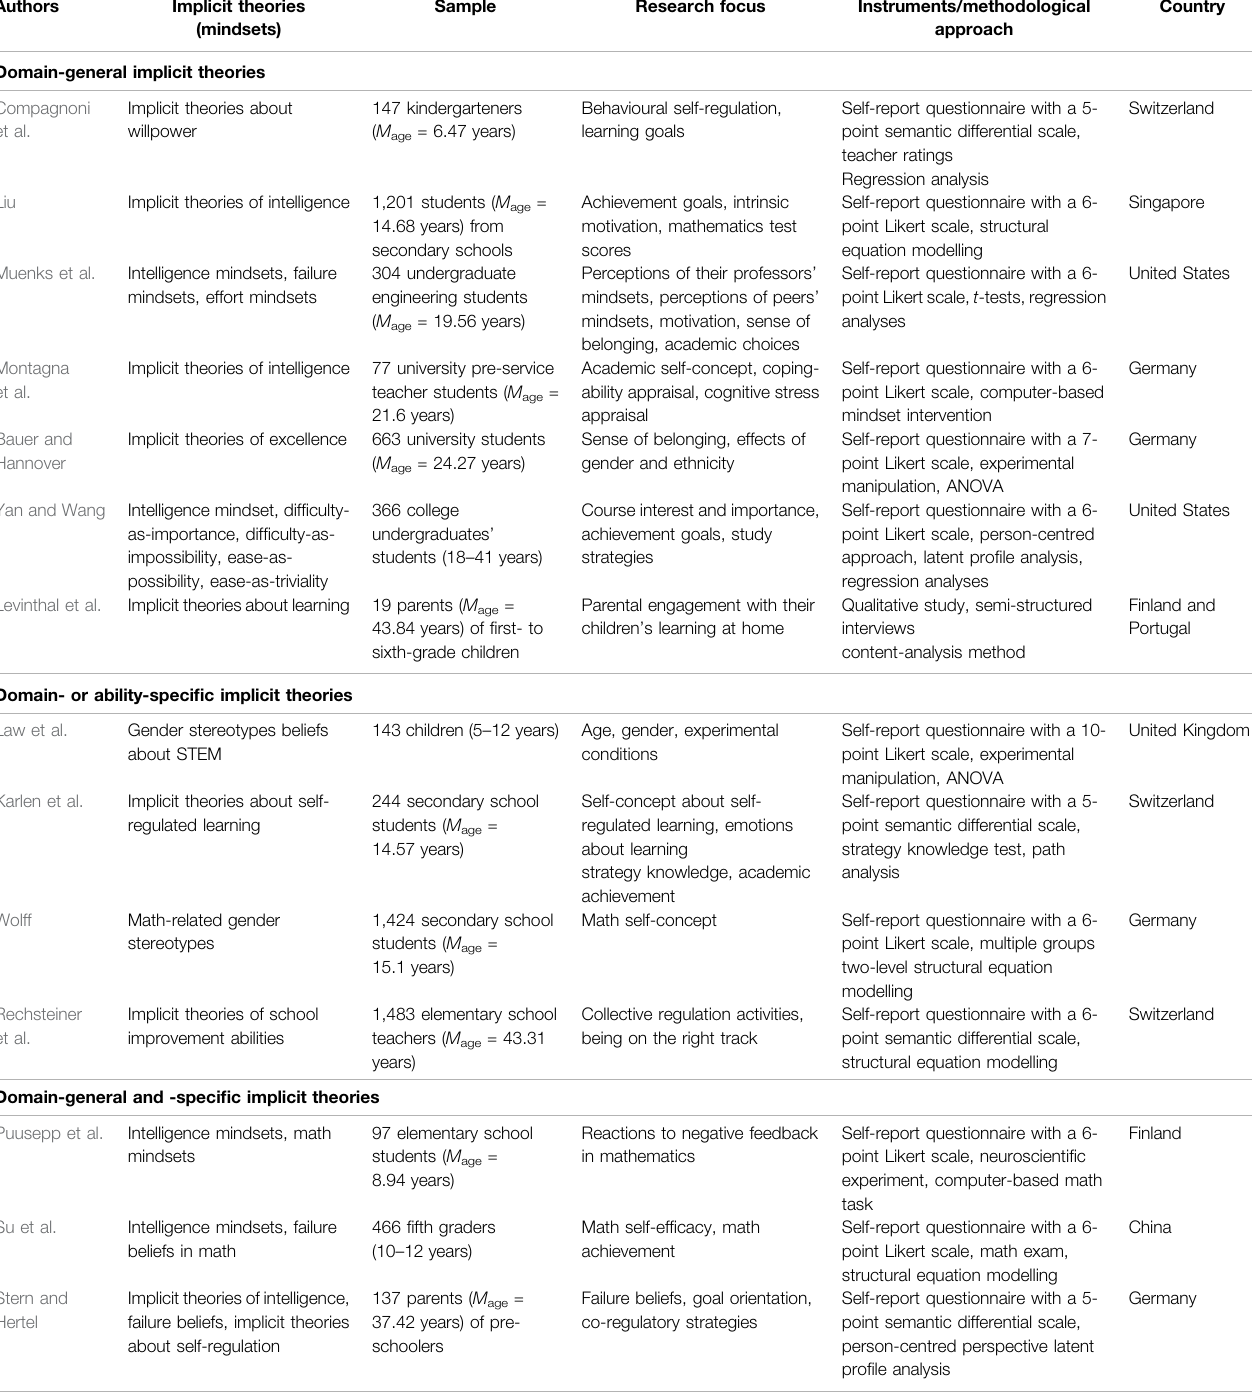
TABLE 1 | Overview of all 14 studies contributing to the Research